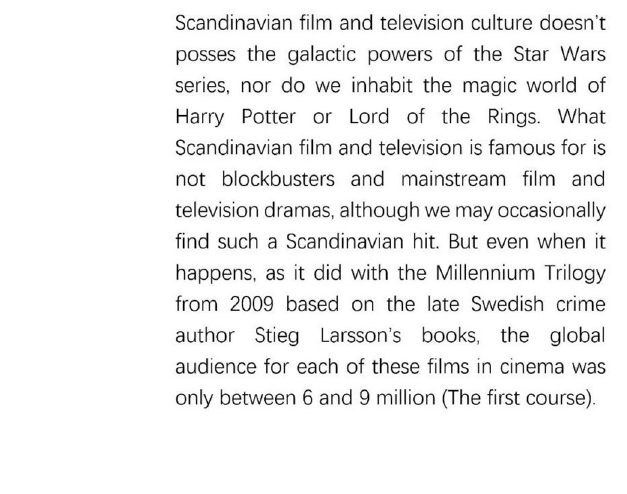
FIGURE 4 | Comparison of two lecture styles (Serious vs.